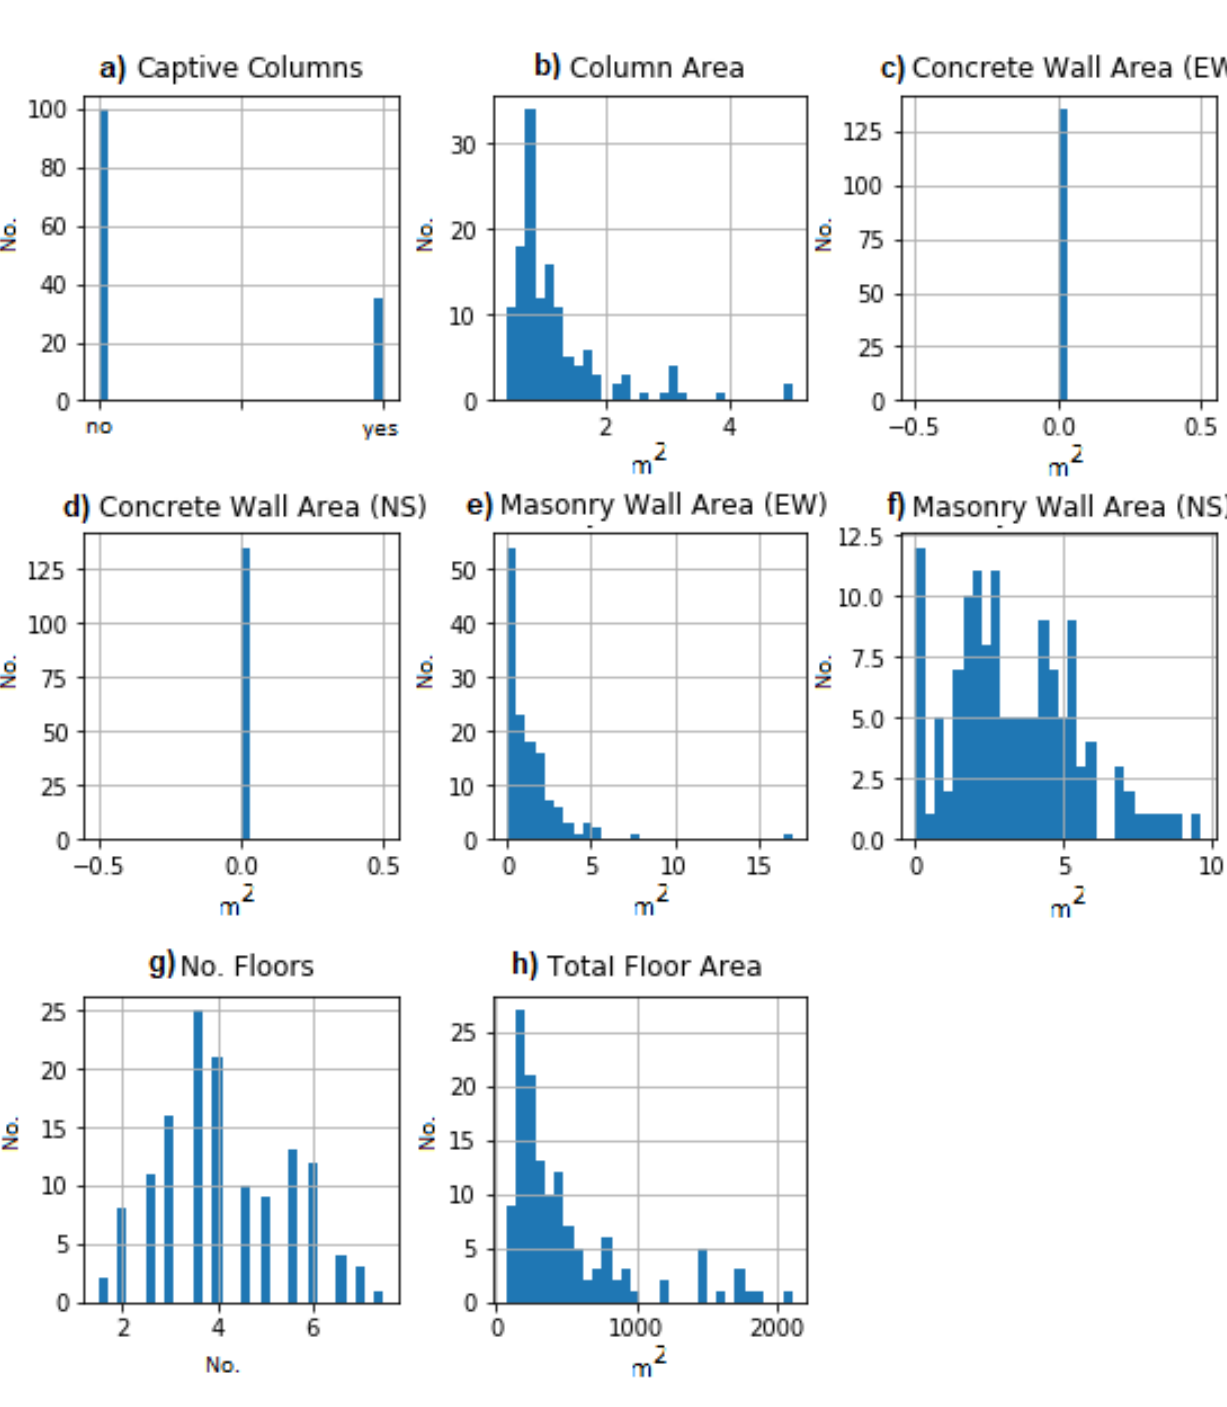
Figure 6. The histogram plot shows the distribution of data of ( a ) Captive Columns, ( b ) Column Area, ( e ) Masonry Wall Area (EW), ( f ) Masonry Wall Area (NS), ( g ) No. of Floor, and h) Total Floor Area for